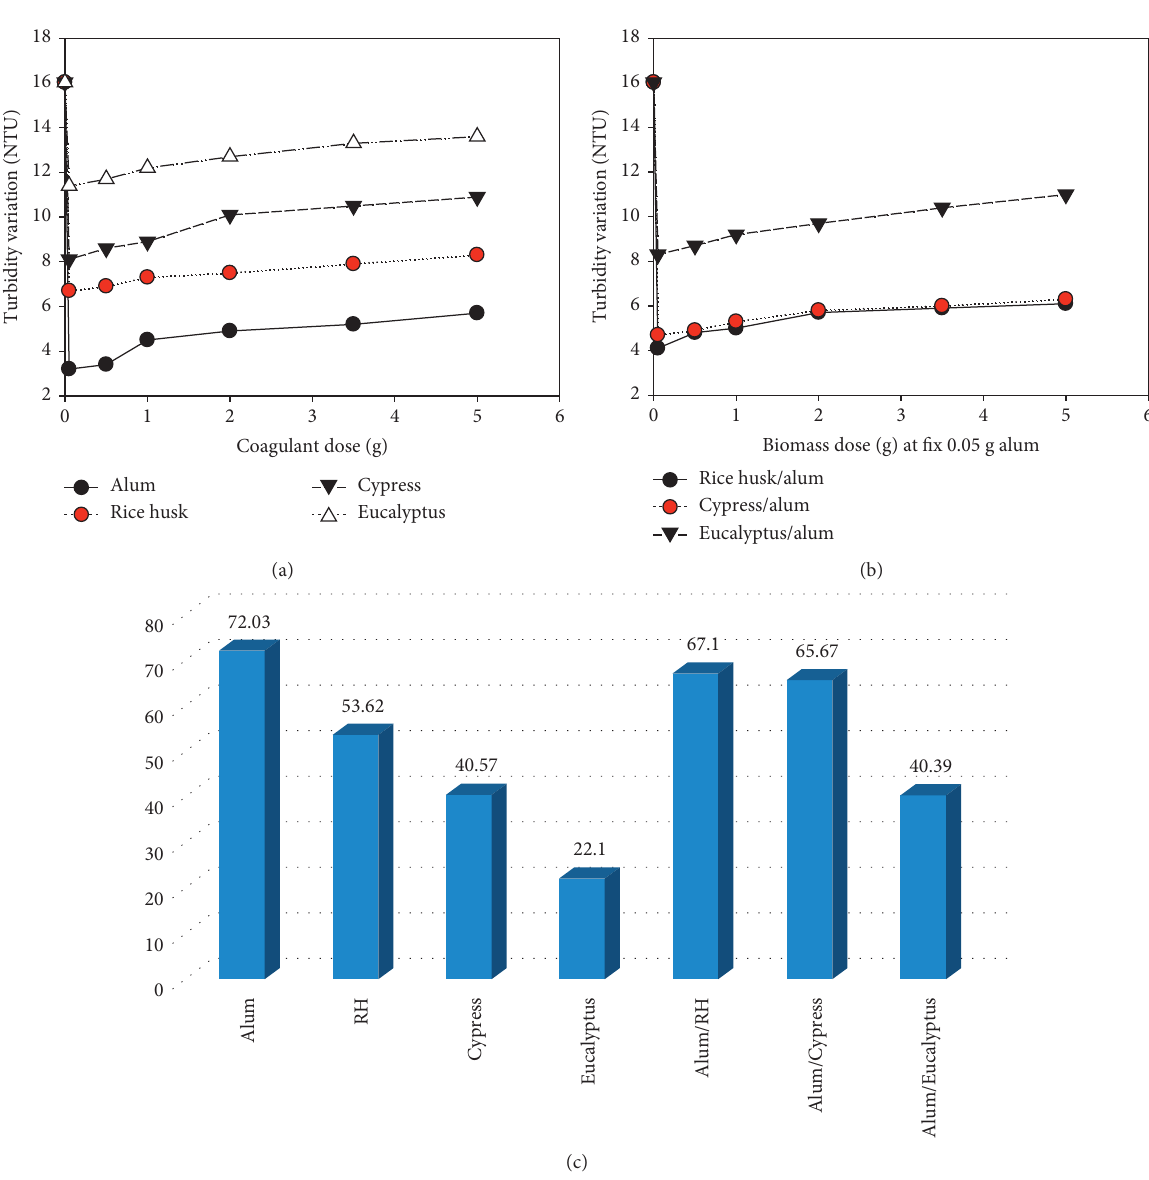
Figure 5: Variation of turbidity of M90 water with (a) individual, (b) mixed coagulants, and (c) coagulation activities